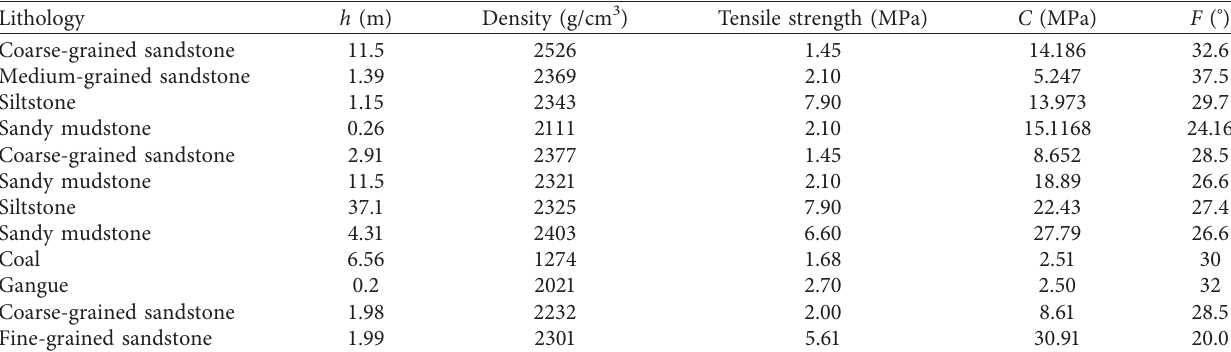
Figure 2: The numerical calculation model. Table 1: Physical and mechanical parameters of the block.